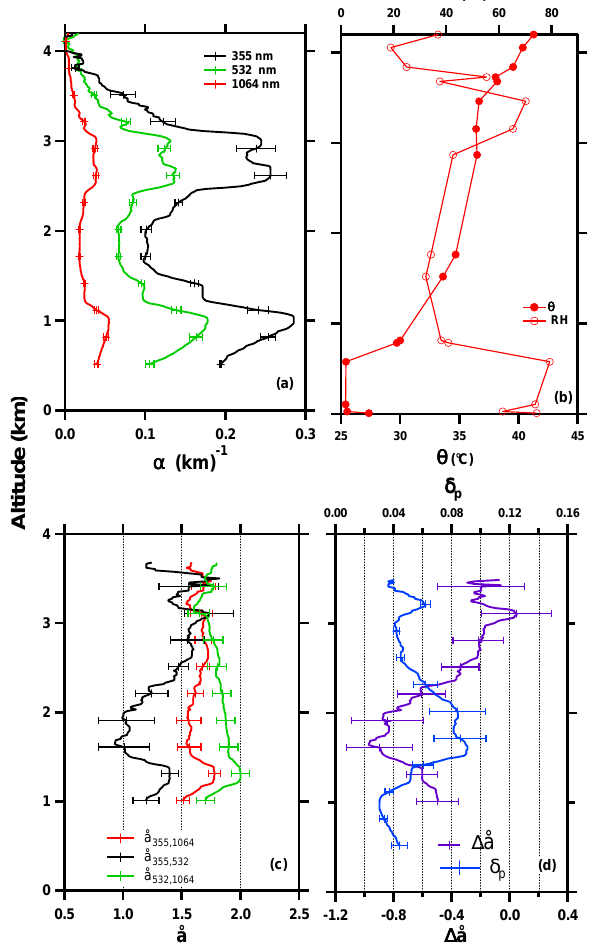
Fig. 5. Extinction coefficient profile at 355nm (black line), 532nm (green line), and 1064nm (red line) retrieved from lidar measure- Figure 5 (M. R. Perrone et al.) 5 ments performed on 29 August 2011 from 11:44 to 12:19UTC. (b) Vertical profiles of potential temperature ( θ) and relative humid- ity (RH) retrieved from radio sounding measurements performed at 11:00UTC. Vertical profiles of (c) the Ångstrom exponents å 355 , 532 (z) , å 532 , 1064 (z) , and å 355 , 1064 (z) and (d) the spectral cur- vature 1 å (z) . The blue line in Fig. 5d represents the vertical profile of the linear particle depolarization